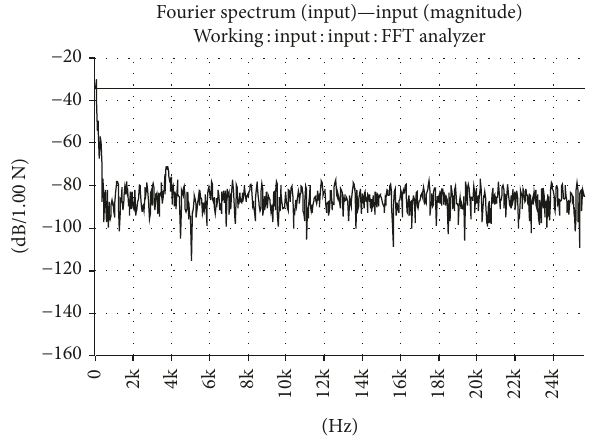
Figure 13: The Fourier spectrum of the input signal.